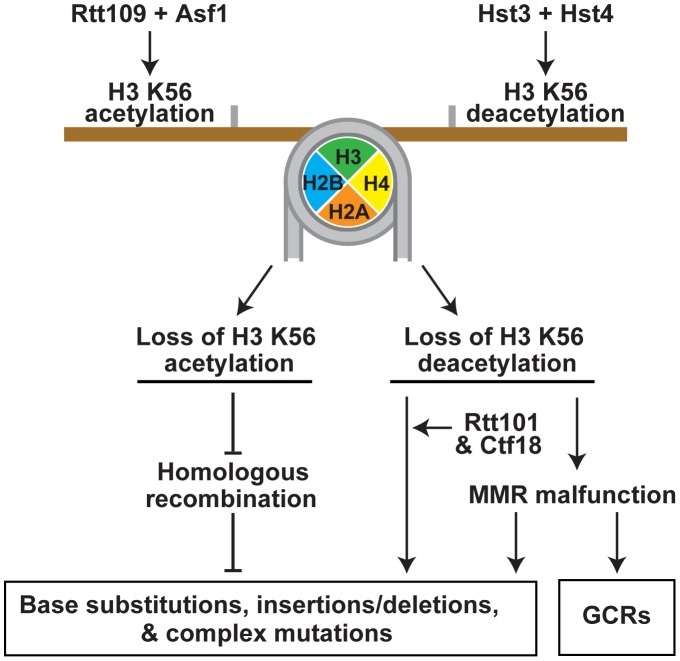
Model that summarizes the importance of the acetylation and deacetylation of H3K56 for the suppression of GCRs, base substitutions, small deletions/insertions, and complex mutations.Rtt109 and Asf1 acetylate newly synthesized histones H3 on K56 prior to their incorporation into chromatin in S phase [37]–[40]. H3K56ac is removed from the new chromatin by Hst3 and Hst4 in G2/M [36], [46], [47]. Hence, in wild-type cells, H3K56ac is present in S phase and G2/M, but absent in G1. In contrast to wild-type cells, rtt109Δ and asf1Δ lack H3K56ac in S phase and G2/M, and hst3Δ hst4Δ cells contain H3K56ac in G1. Furthermore, the levels of H3K56ac in S phase and G2/M in hst3Δ hst4Δ are higher than those in wild type. The imbalance in H3K56ac provides the basis for the different spontaneous mutagenesis in the rtt109Δ and hst3Δ hst4Δ strains.